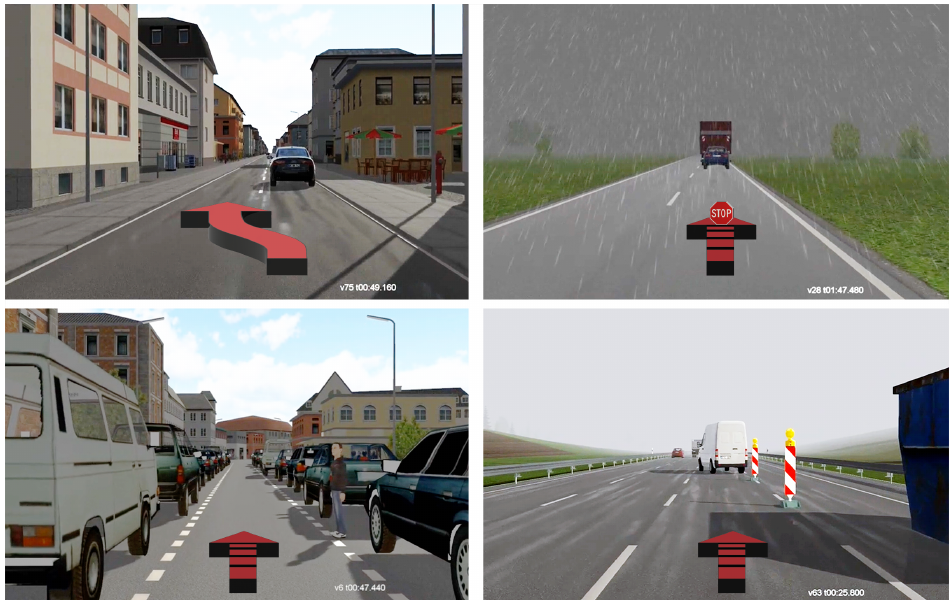
Figure 4. Pictures of critical events of the four scenario clusters: ( top left ) C1—at the beginning of the second take-over; ( top right ) C2—appearance of the stopped truck in the fog; ( bottom left ) C3—appearance of the child between the parked vehicles; ( bottom right ) C4—cut-in of the delivery van from the construction site with nearly zero